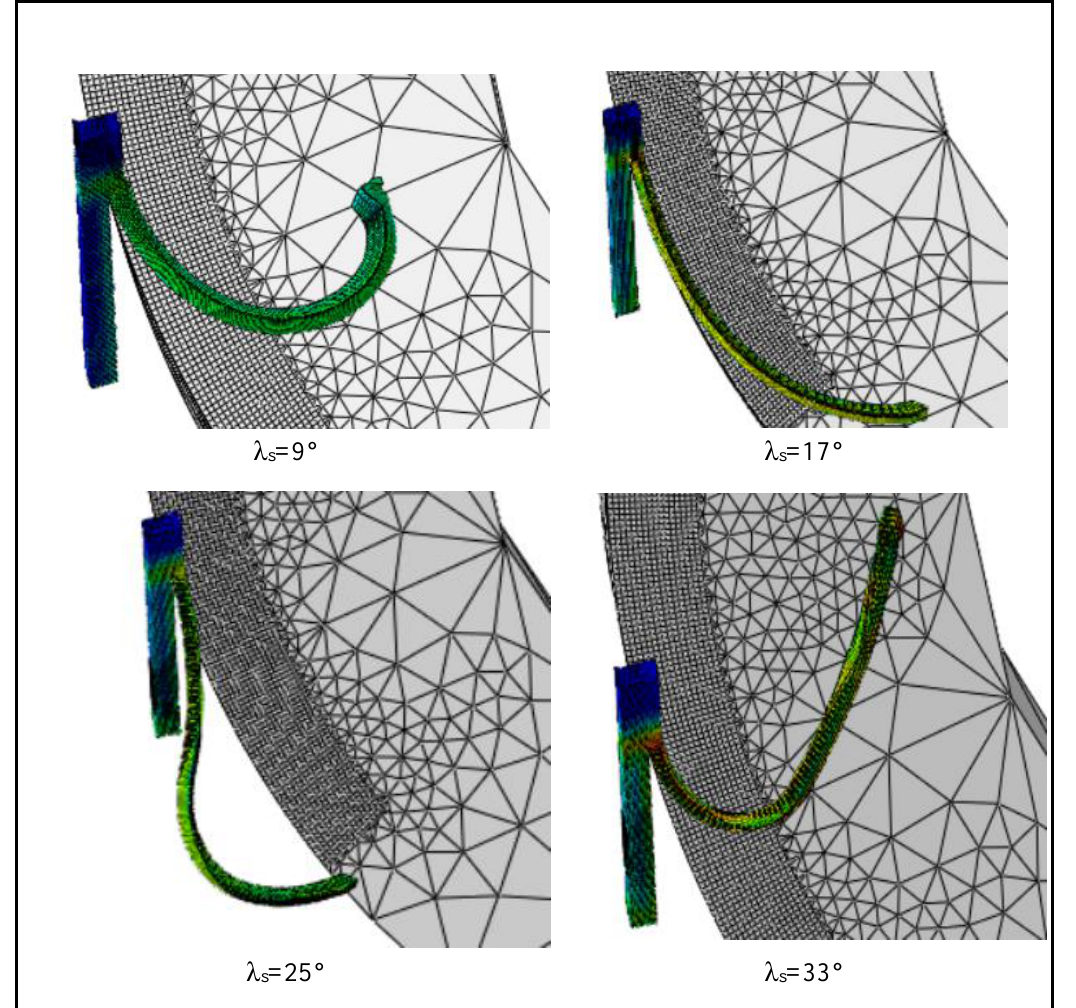
Figure 9. Chip formation at different inclination angles ( V = 100 m/min).